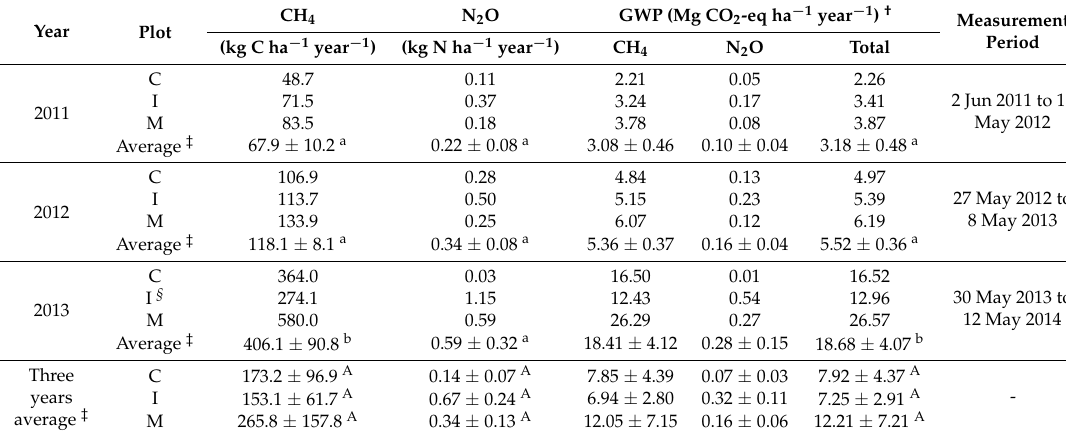
Table 2. Annual methane (CH 4 ) and nitrous oxide (N 2 O) emissions from the rice cultivated field (paddy) for three years